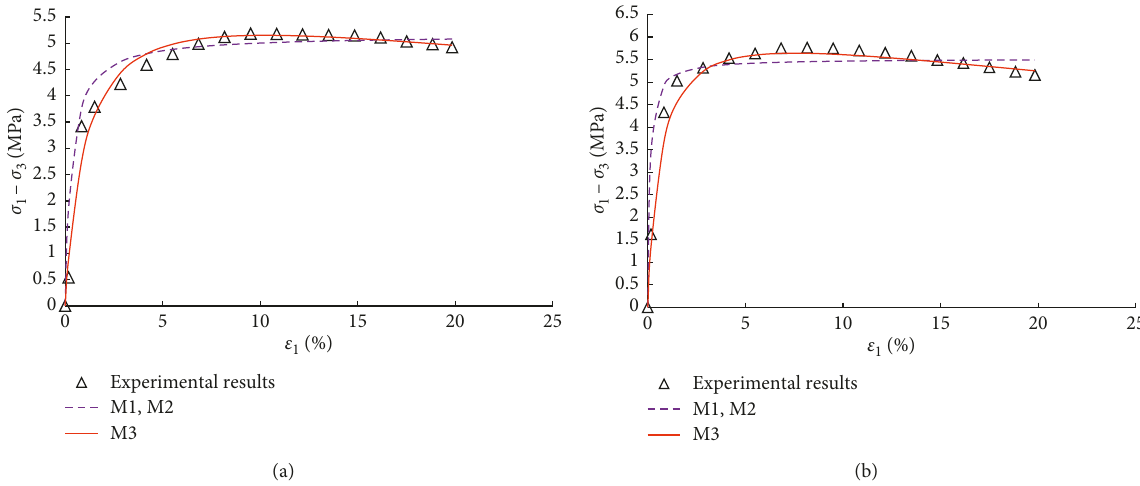
Figure 10: Deviatoric stress-strain strain relationship fitting results for each model at − 5 ° C. (a) T � − 5 ° C, σ